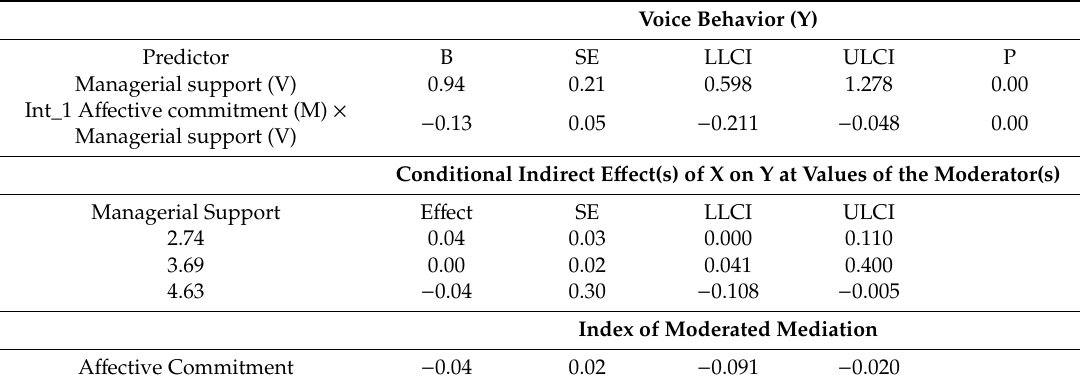
Table 5. Results of moderated mediation